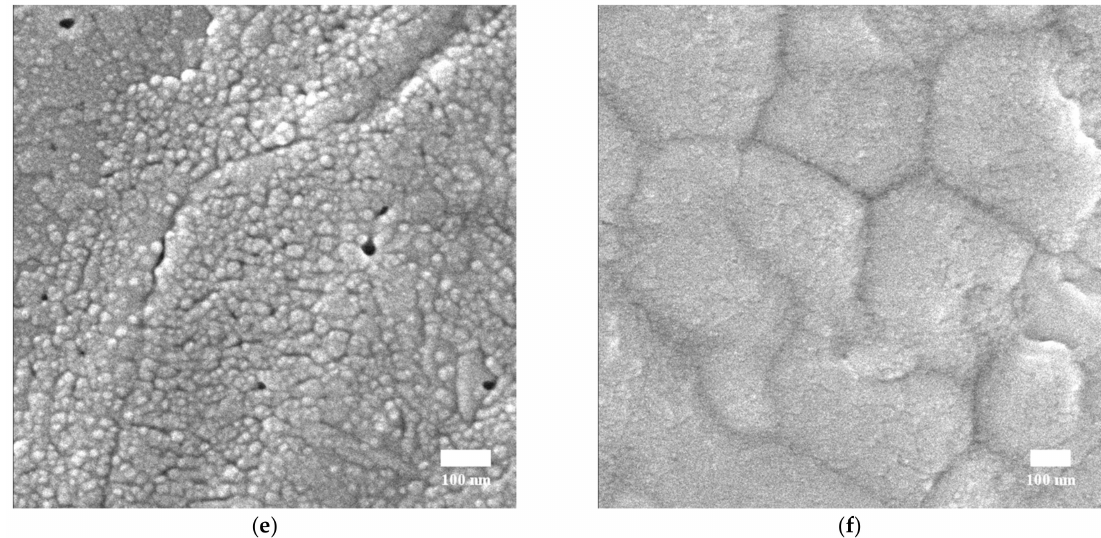
Figure 3. ( a – c ) Top-view SEM images of the MAPbI 3 perovskite films prepared using different solvents. Scale bars = 100 nm. ( d – f ) SEM images of the MAPbI 3 perovskite